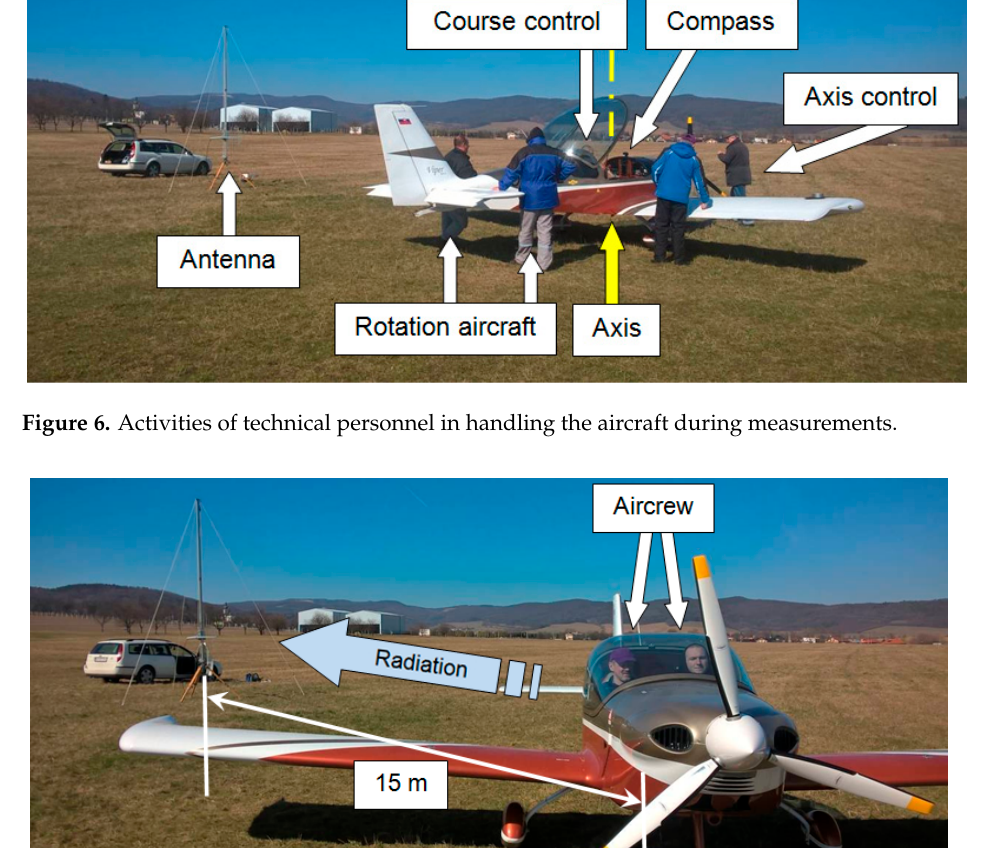
Figure 6. Activities of technical personnel in handling the aircraft during measurements.